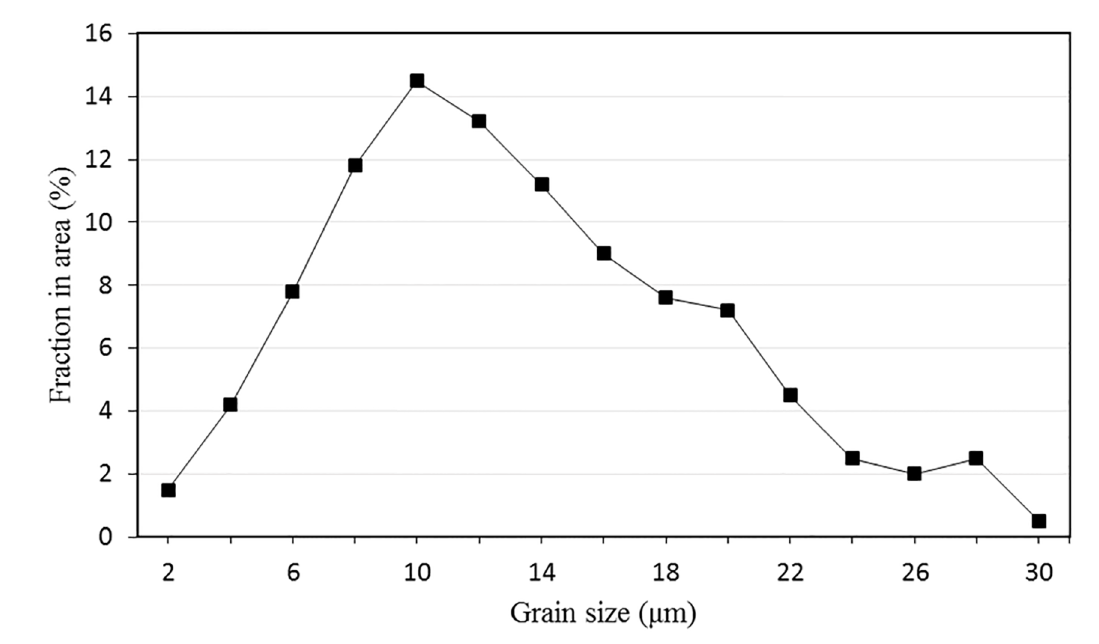
Figure 4 . Equivalent diameter distribution of Inconel 625 annealed grains obtained by EBSD, with mean value of 14